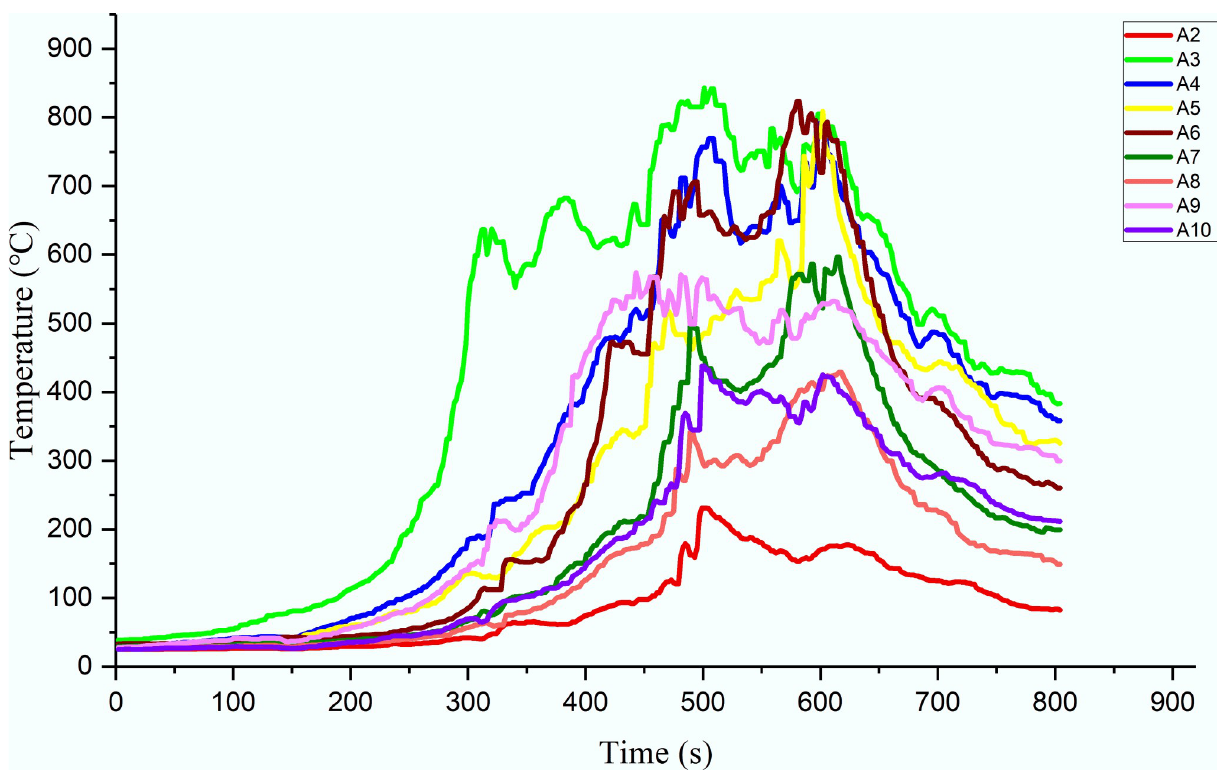
Fig 7. Smoke-temperature variation in the